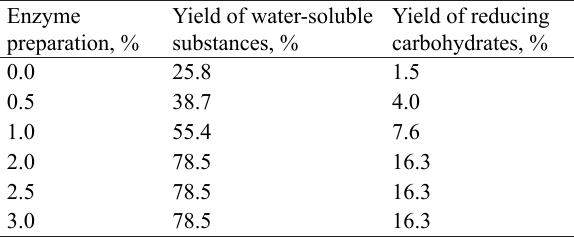
Table 3 Yield of water-soluble substances and reducing carbohydrates according to the amount of enzyme preparation Enzyme Yield of water-soluble Yield of reducing preparation, % substances, % carbohydrates,